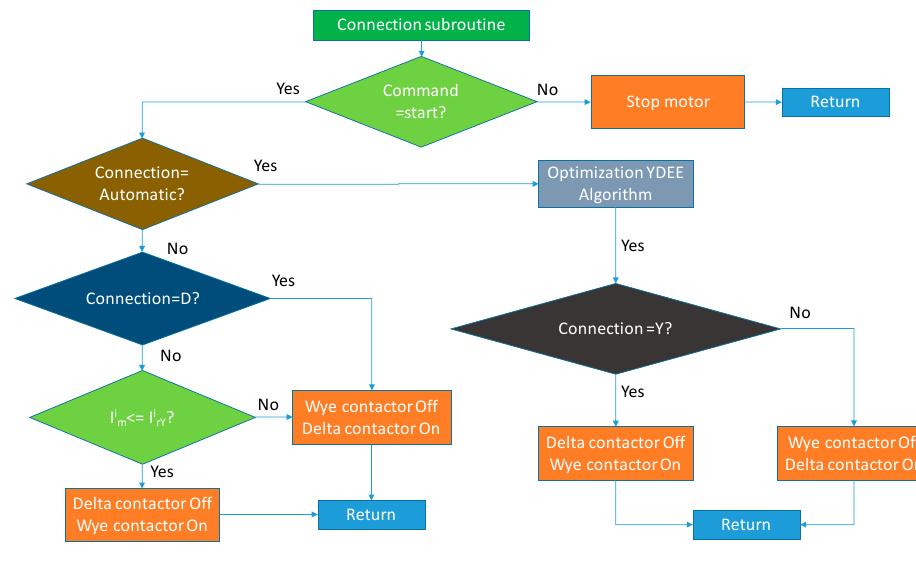
Figure 6. IMEMSL connection subroutine.